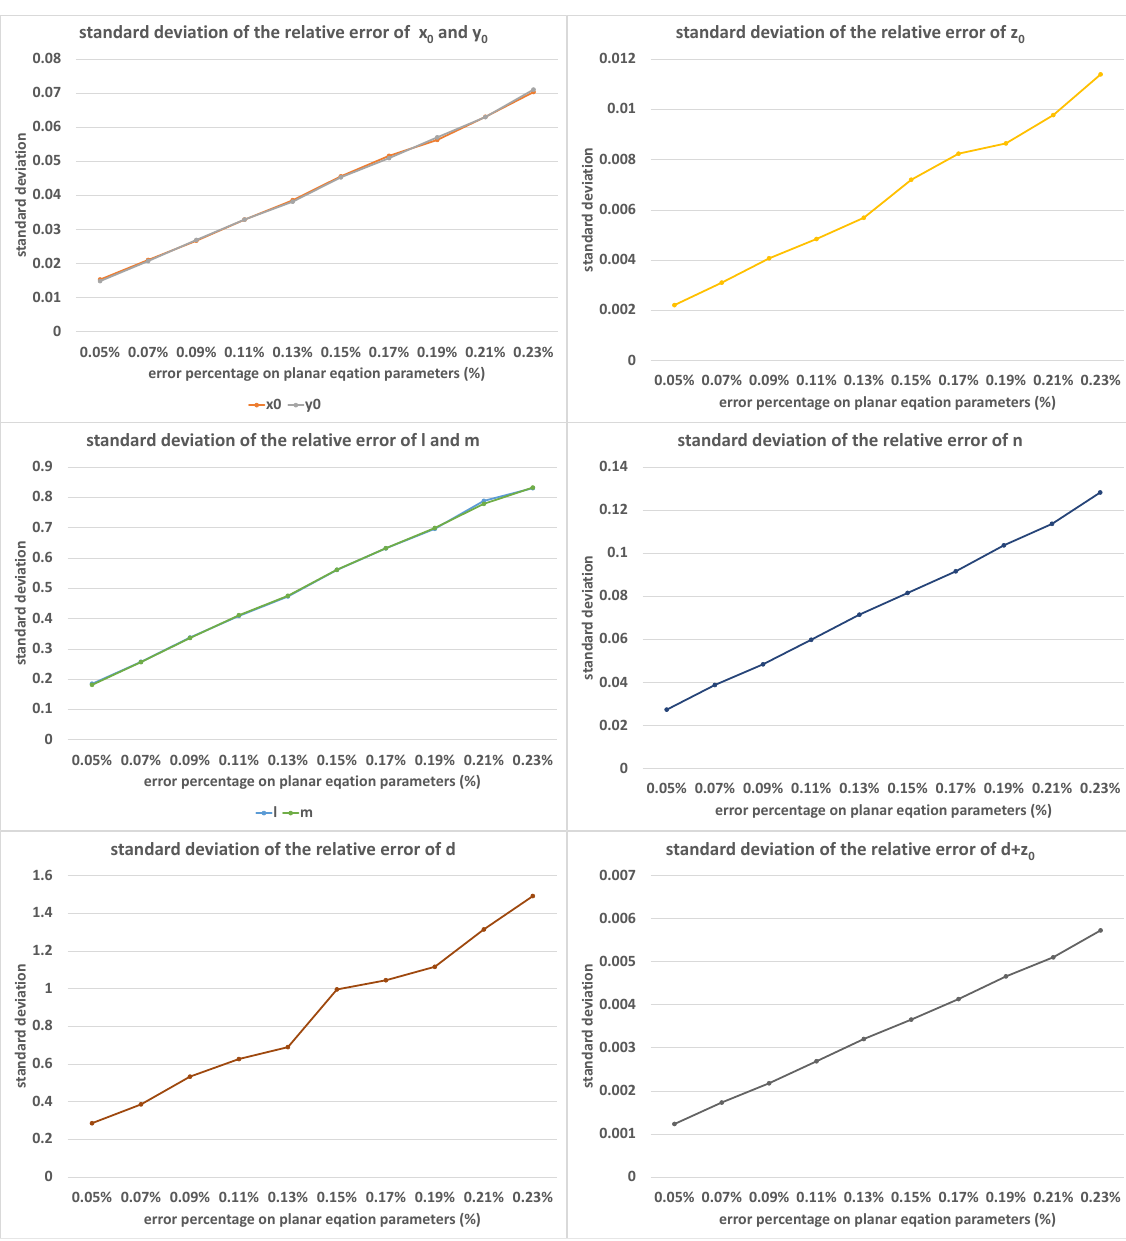
Figure 8. The standard deviations of relative errors of ( x 0 , y 0 , z 0 , l , m , n , d , d + z 0 ) with the increase in δ ; the horizontal axis was measured as